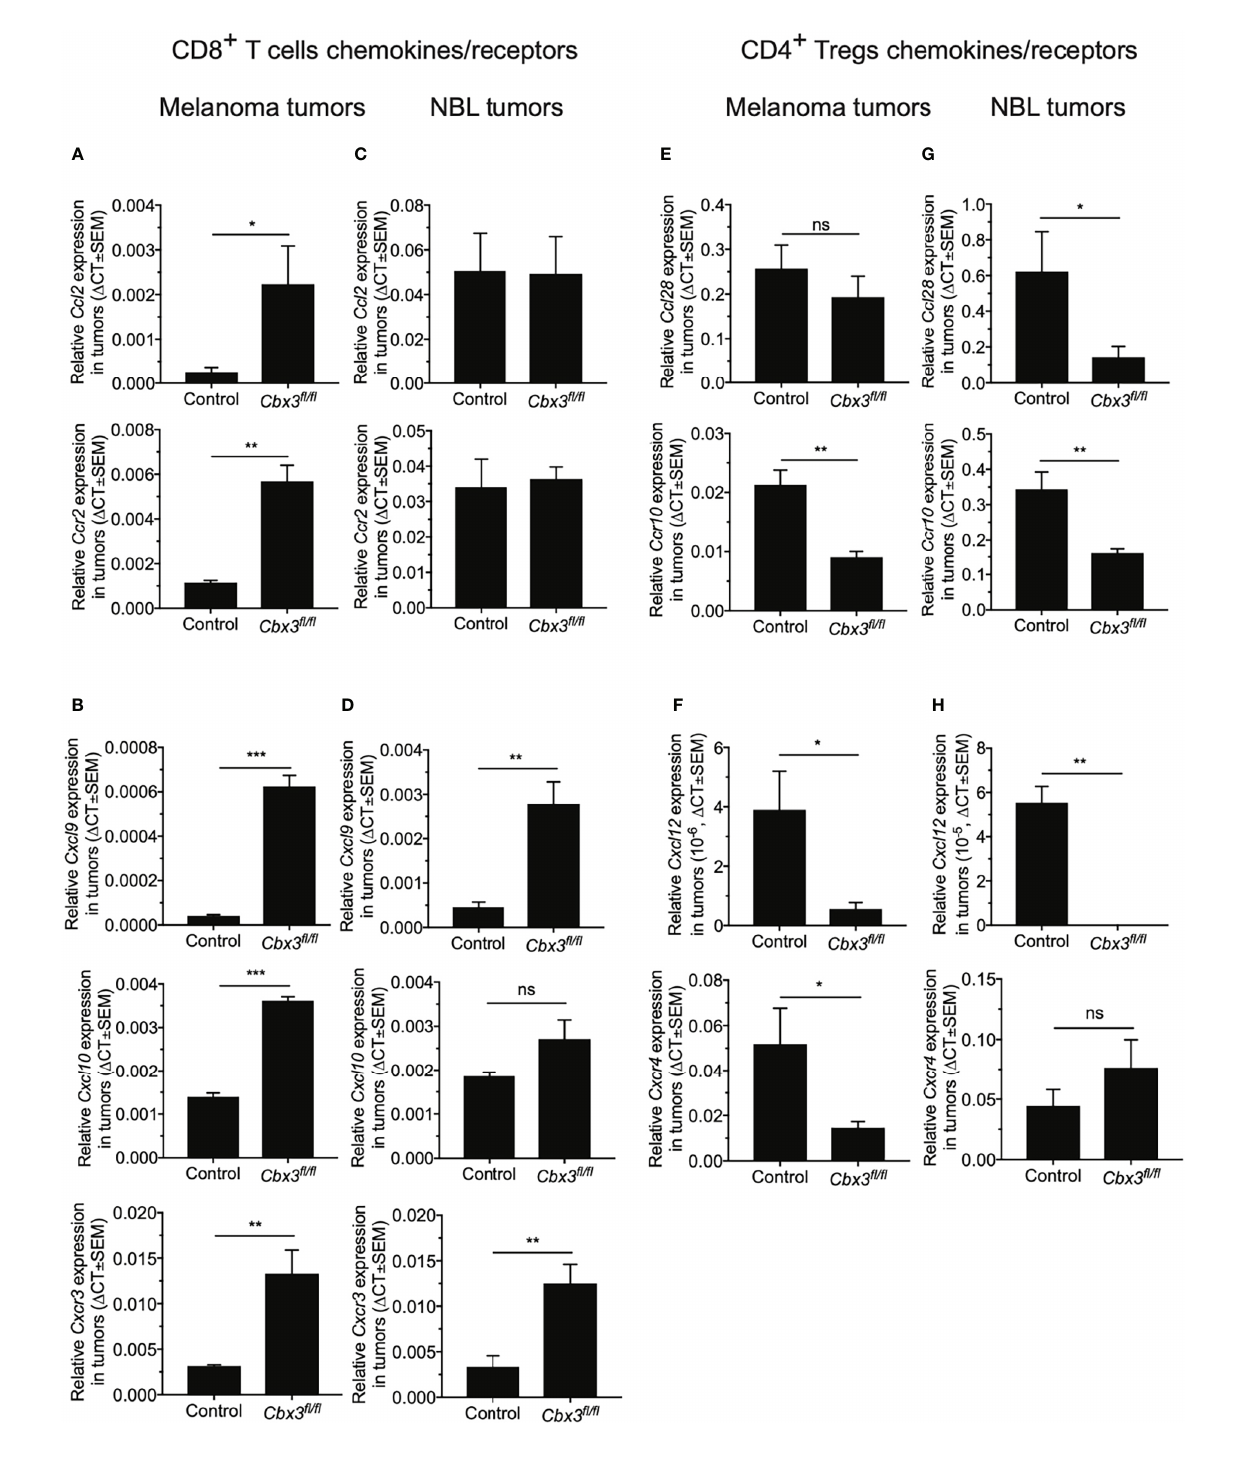
FIGURE 4 | Cbx3 /HP1 g -de fi cient CD8 + T cells remodel the tumor chemokine/receptor landscape. (A, B) Relative expression of chemokines and receptors mediating CD8 + T cells traf fi cking into B16 tumors was determined by RT-qPCR and normalized to Gapdh . (C, D) Relative expression of chemokines and receptors mediating CD8 + T cells traf fi cking into NBL tumors was evaluated by RT-qPCR and normalized to Gapdh . (E, F) Relative expression of chemokines and receptors inducing CD4 + Tregs homing into tumors was normalized to Gapdh . (G, H) Relative expression of chemokines and receptors inducing CD4 + Tregs homing into NBL tumors was assessed. X axis: mouse strains; Graphpad unpaired student t-test: *p ≤ 0.05, **p ≤ 0.01, ***p ≤ 0.001; ns, not signi fi cant; representative of 4 experiments; n =